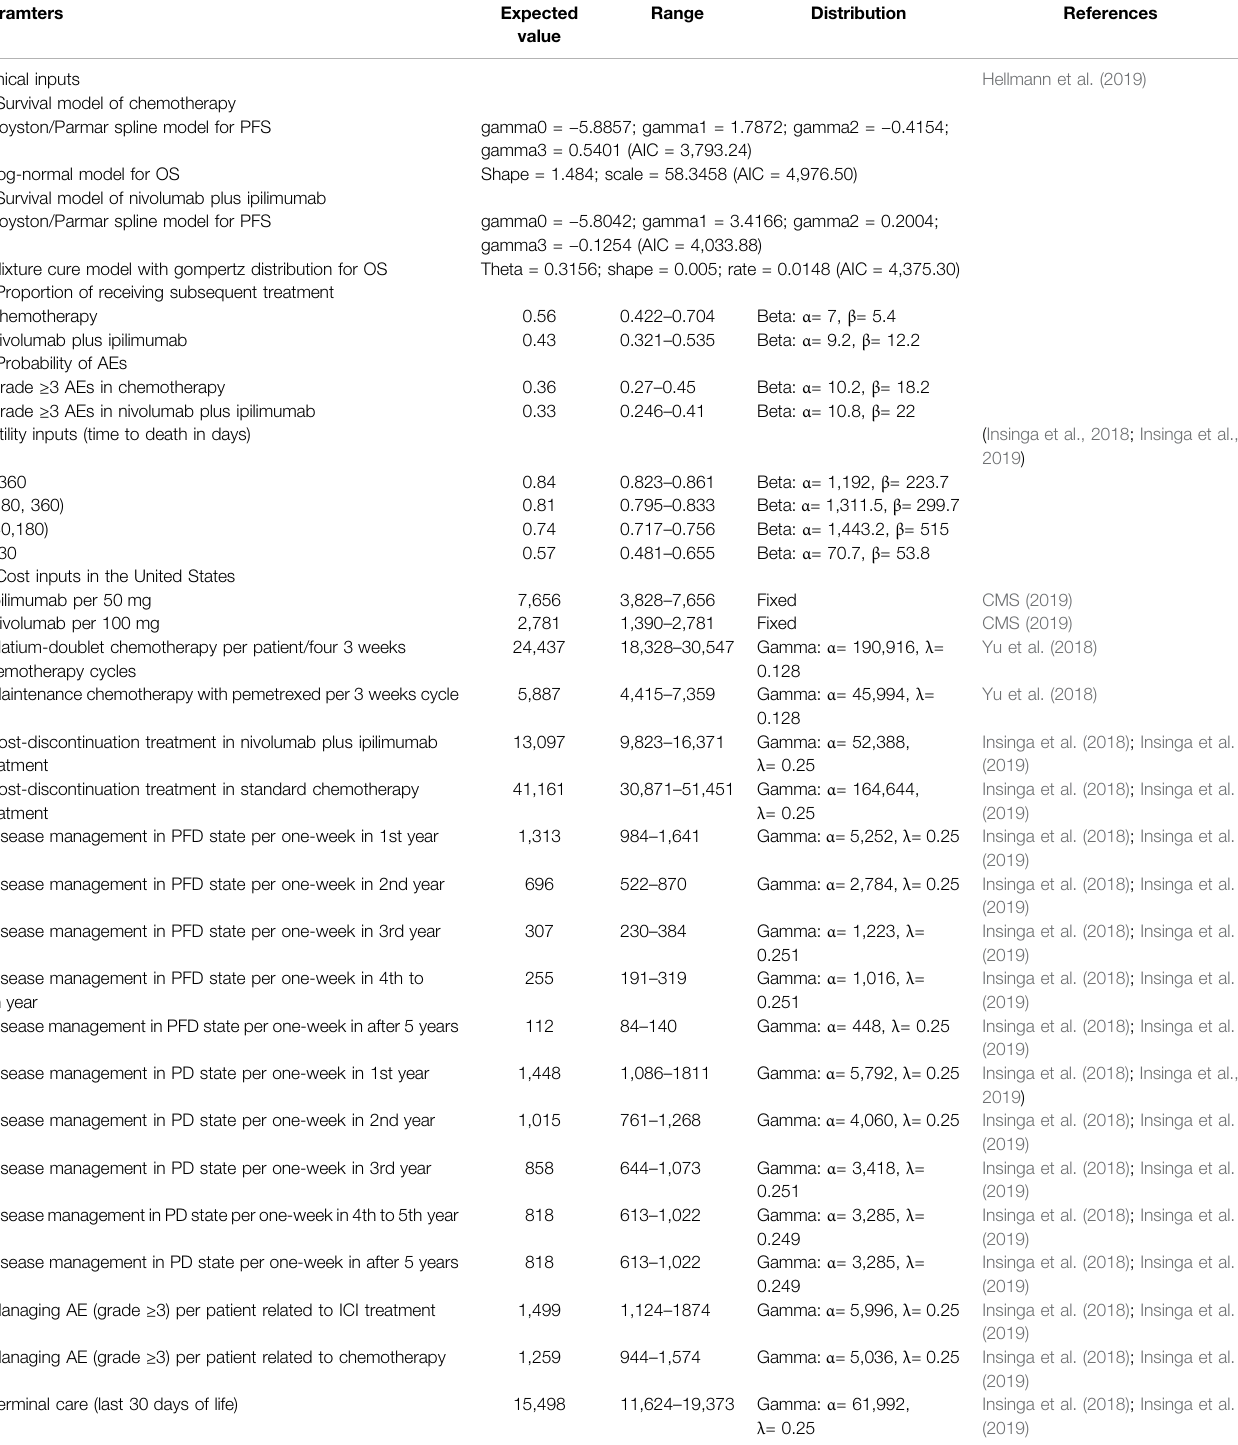
Abbreviations: AE, adverse event; PFS, progression-free survival; PFD, progression-free disease; PD, progressed disease; OS, overall